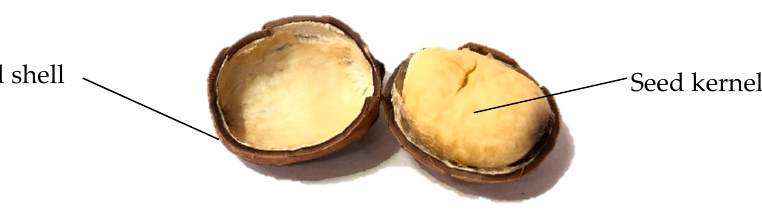
Figure 1. Seed shell and kernel of Jatropha curcas L.